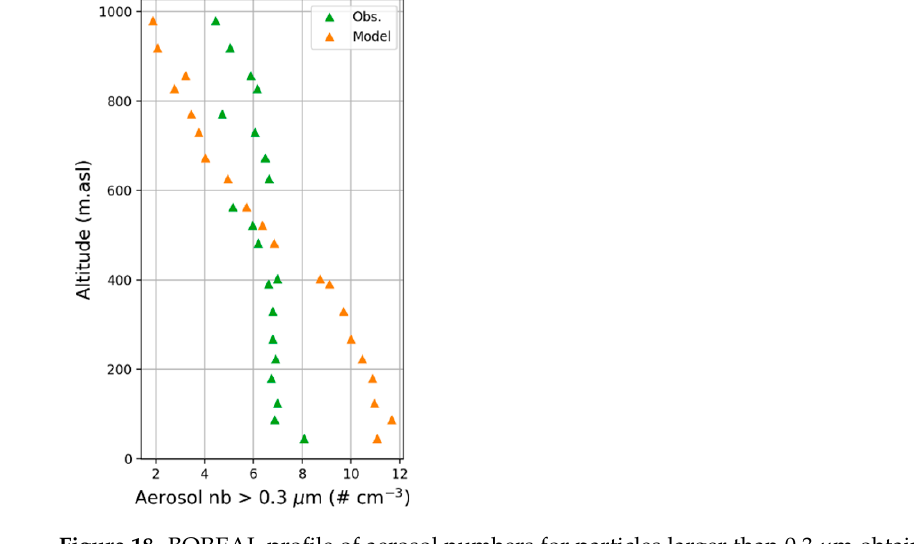
Figure 18. BOREAL profile of aerosol numbers for particles larger than 0.3 µ m obtained with the onboard Optical Particle Counter (green) and simulated with the OWA model (orange).